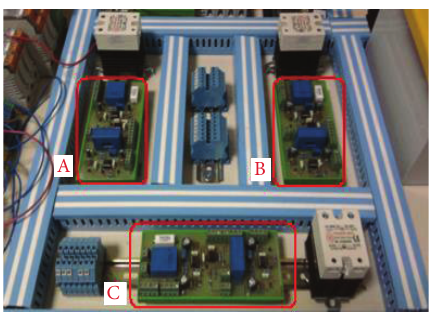
Figure 15: Developed electronic measurement cards and circuit breakers.